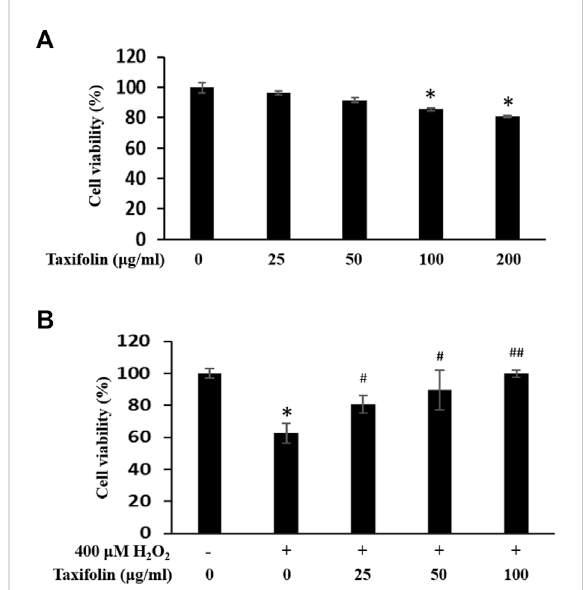
FIGURE 7 (A) Endogenous cytotoxicity of taxifolin inHDFPC. Cells were incubated with the indicated doses of taxifolin. Cell viability was calculated as described in Materials and methods . Data are expressed as the Mean ± SD. * p < 0.05 vs. non-treated group. (B) Inhibitory effect of taxifolin on hydrogen peroxide- induced cytotoxicity in HDFPC. Cells were pre-incubated with the indicated doses of taxifolin for 20 min and further treated 400 μ M H 2 O 2 for12 h.Cellviabilitywascalculatedasdescribedin Materials and methods . Data are expressed as the Mean ± SD. * p < 0.005 vs. non-treated group. # p < 0.05 and ## p < 0.005 vs. control group